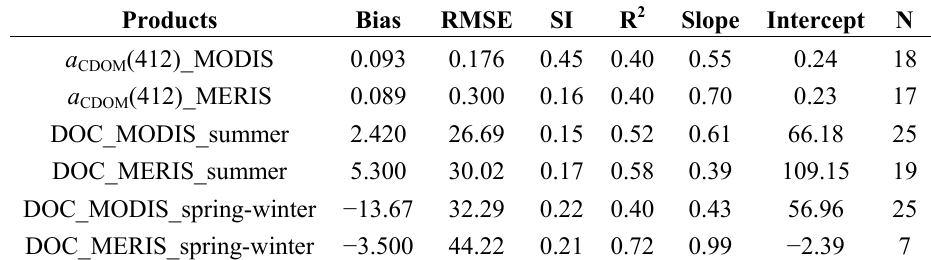
Table 7. Summary of error statistics obtained from validation matchup comparisons for a (412) and DOC derived from MODIS and MERIS for the summer and CDOM spring-winter